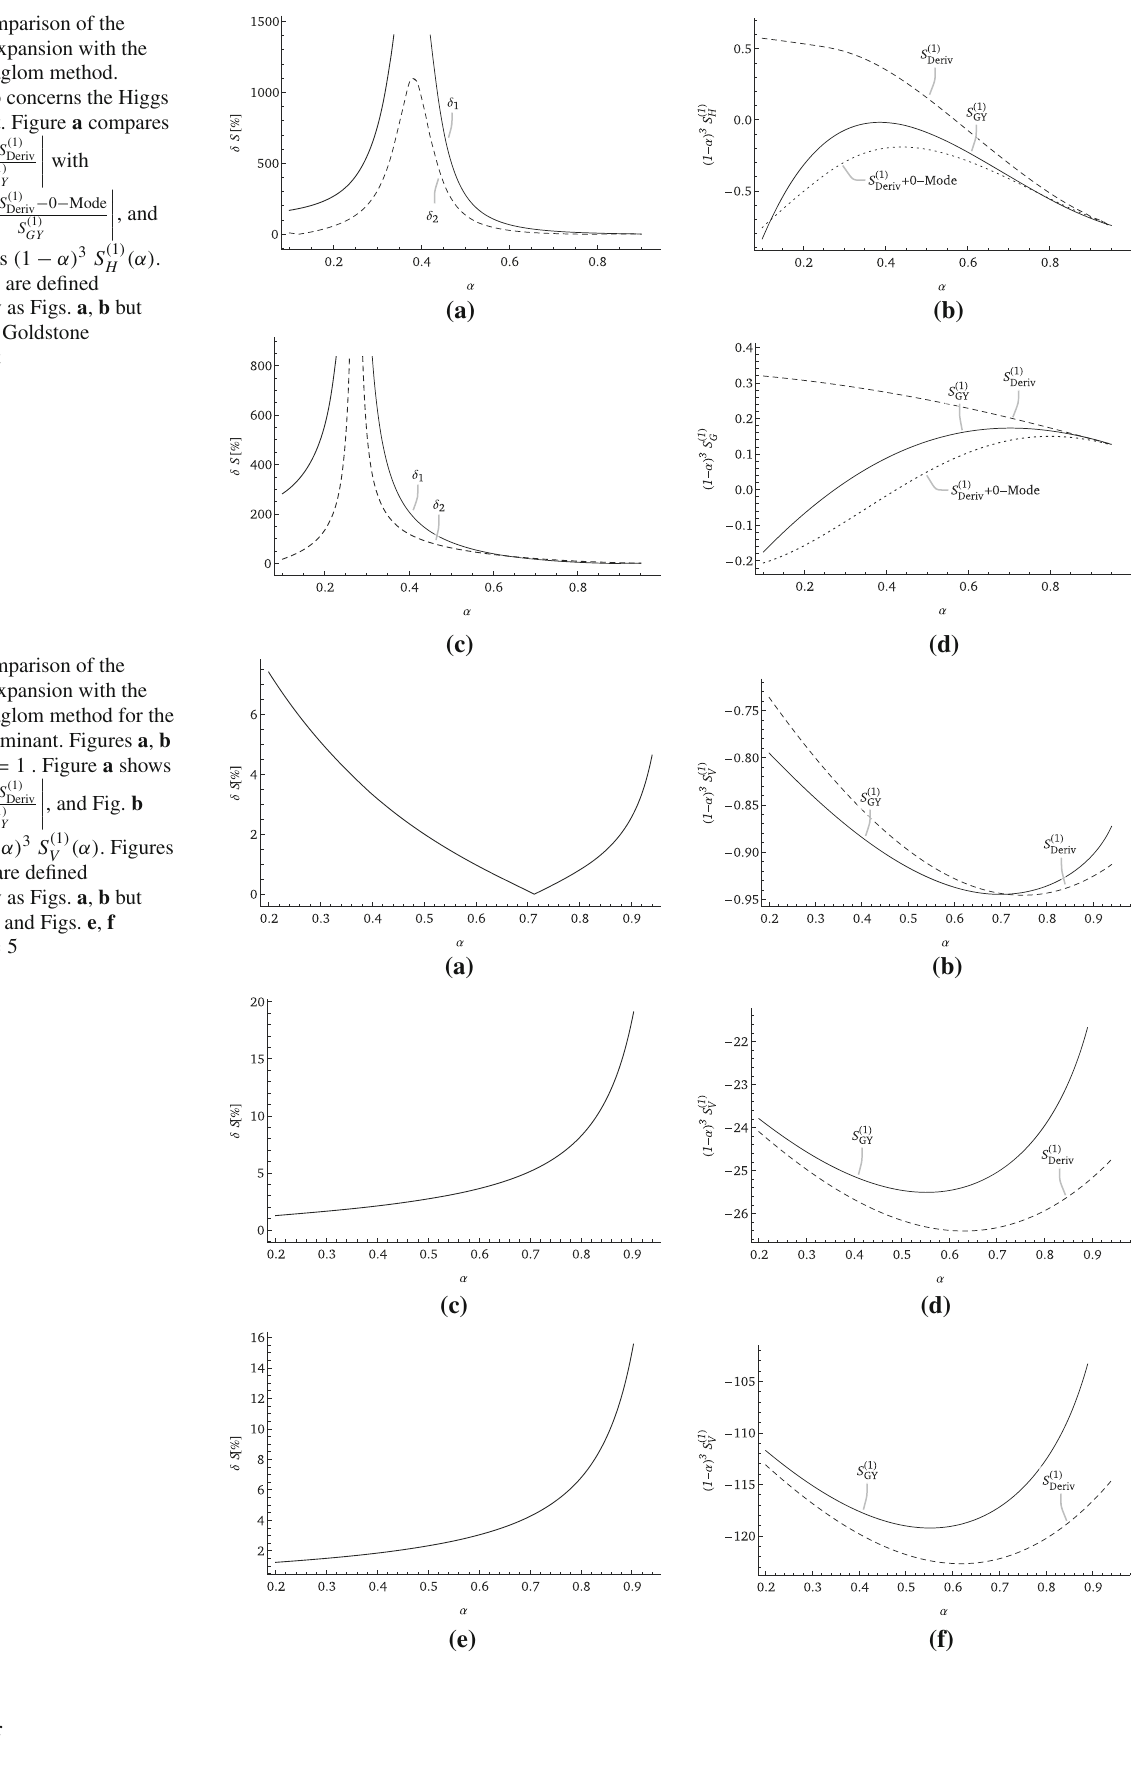
Fig. 3 Comparison of